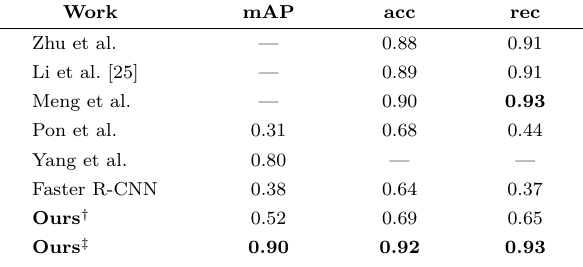
Table 1 Detection results: performance of state-of-the-art works. acc : accuracy. rec : recall. Results of only using Faster R-CNN for the task are also shown. Ours † : proposed framework with few block proposals for high speed. Ours ‡ : proposed framework adjusted for best accuracy. Our proposed framework achieves the best recall and accuracy. The proposed BlockNet significantly boosts detection recall and accuracy with respect to a standard two-shot detection framework (Faster R-CNN)